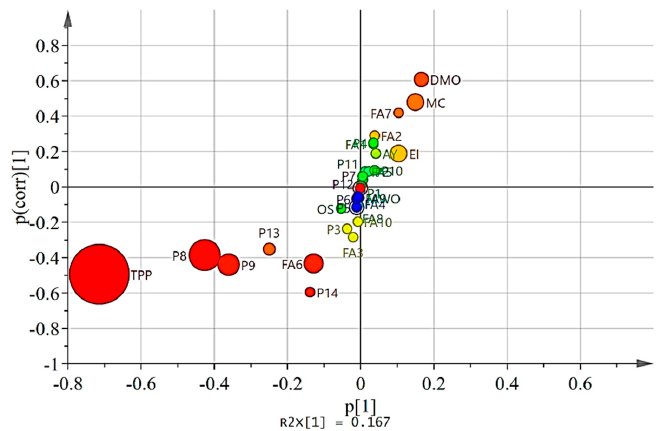
Figure 4. S-Plot providing the visualization of variables affected by maturity index. The circular size was positively correlated with the degree of influence. 1 Dry matter oil content (DMO); moisture content (MC); wet matter oil content (WMO); extractability index (EI); abencor yield (AY); palmitic acid (FA1); palmitoleic acid (FA2); heptadecanoic acid (FA3); heptadecenoic acid (FA4); stearic acid (FA5); oleic acid (FA6); linoleic (FA7); linolenic acid (FA8); arachidic acid (FA9); arachidonic acid (FA10); hydroxytyrosol (P1); tyrosol (P2); vanillic acid (P3); caffeic acid (P4); vanillin (P5); p- coumaric acid (P6); elenolic acid (P7); oleacein (P8); oleocanthal (P9); acetoxypinoresinol (P10); luteolin (P11); apigenin (P12); oleuropein aglycone(P13); ligstroside aglycone (P14); total phenolic content (TPP); oxidative stability (OS). 4. Conclusions To conclude, great variability in oil content, extraction yield, fatty acids, phenolics, and oxidative stability associated with VOO from ten cultivars grown in Wudu was found. MI most affected the level of oil content, oleic acid and secoiridoids. In addition, after genetic breeding improvement, compared with the parent variety Ascolana tenera , Zhongshan24 VOOs significantly improved in oil quantity and quality. The chemical composition of VOOs in Wudu was in accordance with those in VOOs from Mediterranean countries, while the former had a higher level of PUFAs and a relatively lower content of oleuropein aglycone and ligstroside aglycone. The factors that cause differences in VOO characteristics and secondary metabolism need to be further discussed. The OPLS–DA model identified and classified varietal characteristics based on varietal parameters, which had positive implications for sensory regulation and harvesting in the VOO management process, as well as offering the possibility of varietal traceability. These findings contribute to varietal selection, improvement and harvesting in olive practice for local governments. Supplementary Materials: The following supporting information can be downloaded at: www.mdpi.com/xxx/s1. Figure S1. Mass spectrogram of Zhongshan24 virgin olive oils by LTQ- Orbitrap XL; Figure. S2. OPLS-DA permutation analysis (a, b, c, d, e): ten varieties (a), 'Koroheiki ' vs others (b), 'Manzanilla ' vs others (c), ' Ascolana tenera, Arbequina and Zhongshan24 ' vs others (d),' Ezhi8, Ulliri Bardhe, Empeltre, Yuntai14 and Picual ' vs others (e); Figure S3. OPLS permutation analysis for the maturity index model; Table S1 Main phenolic compounds identified in a representative extract of Zhongshan24 virgin olive oils by LTQ-Orbitrap XL; Table S2 The relative importance of varieties and maturity index and significance in the PERMANOVA for all the variables analyzed (expressed as percentages of total sum of squares, %); Table S3 Physical indicators of virgin olive oils from ten cultivars with three maturity indexes in Wudu (%); Table S4 Fatty Acid composition of virgin olive